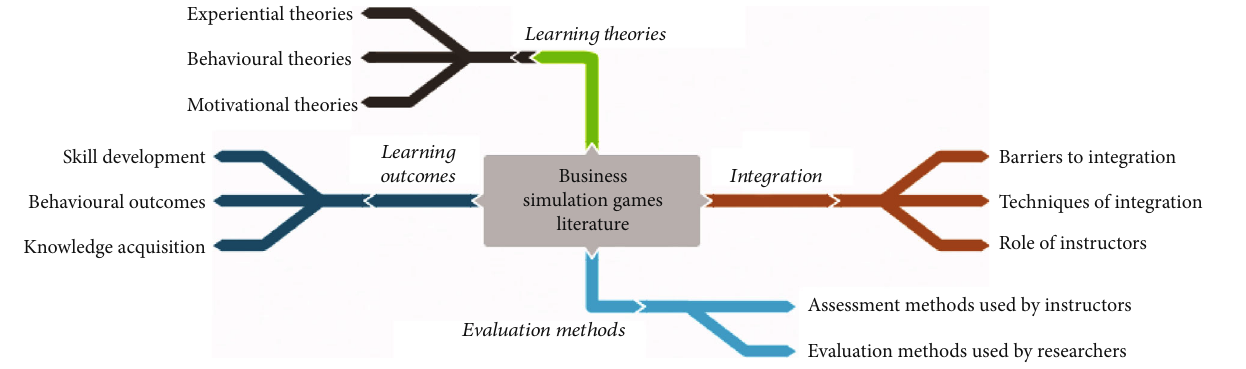
Figure 2: Themes in BSG